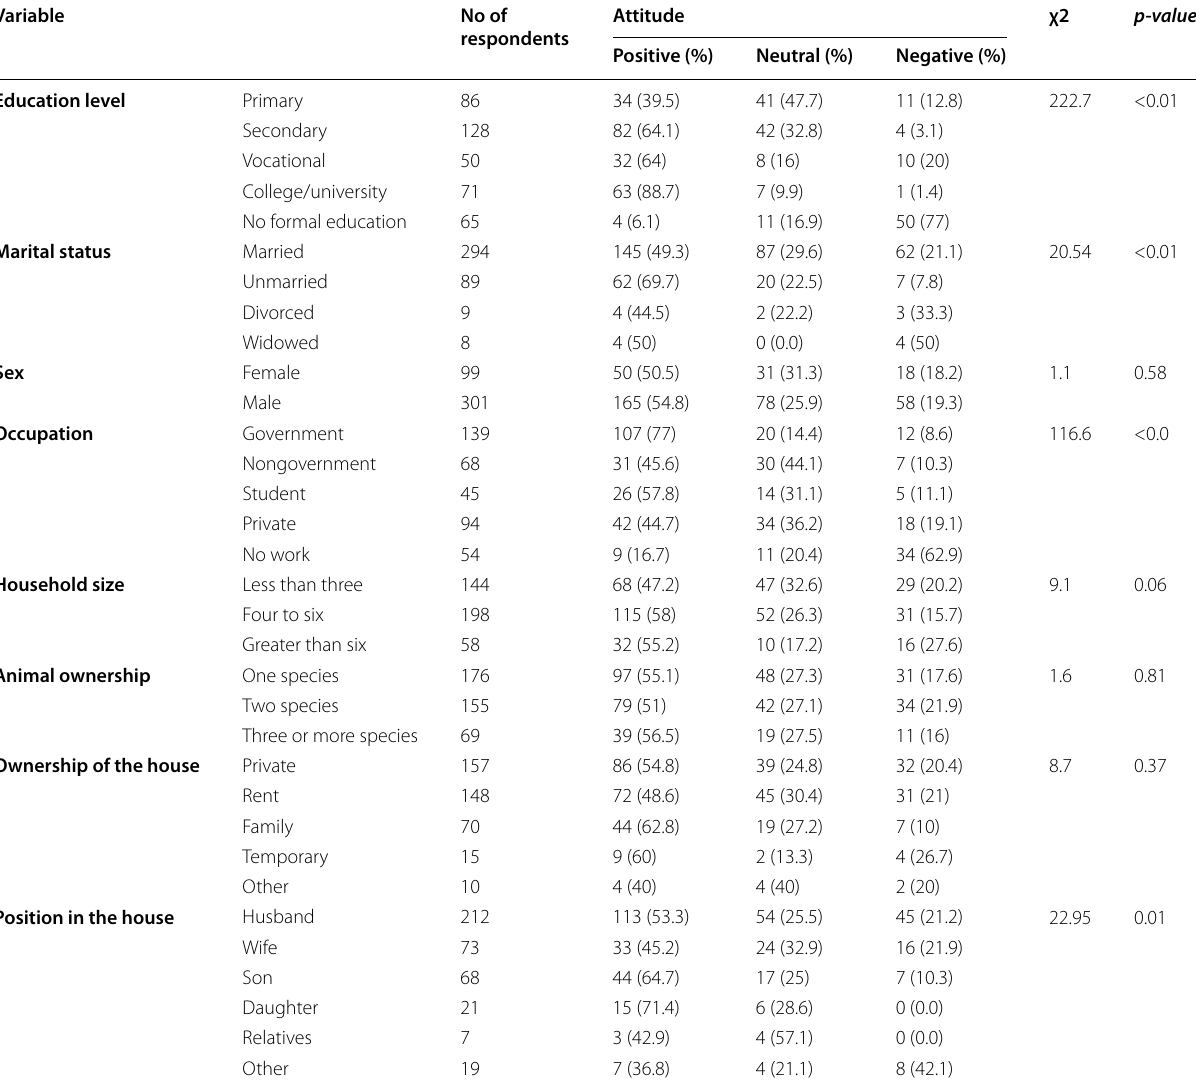
Table 6 Association of attitudes with demographic characteristics